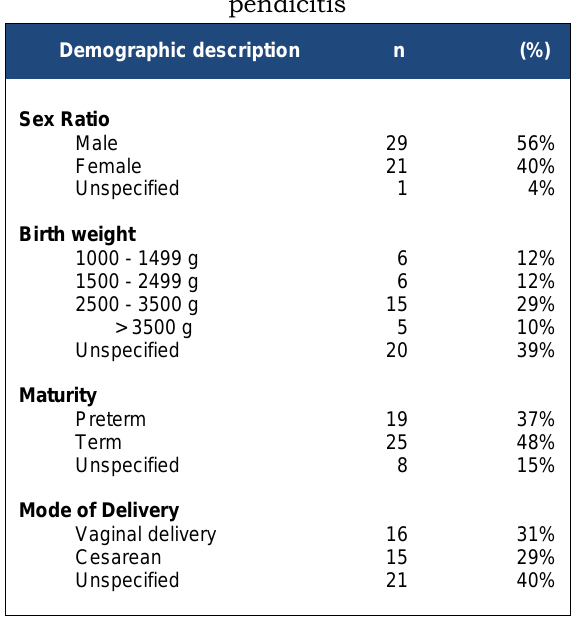
Table 2: Clinical features of Neonatal